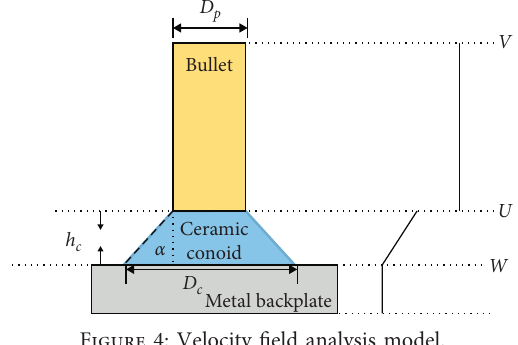
Figure 6: Ceramic conoid working on a metal plate.